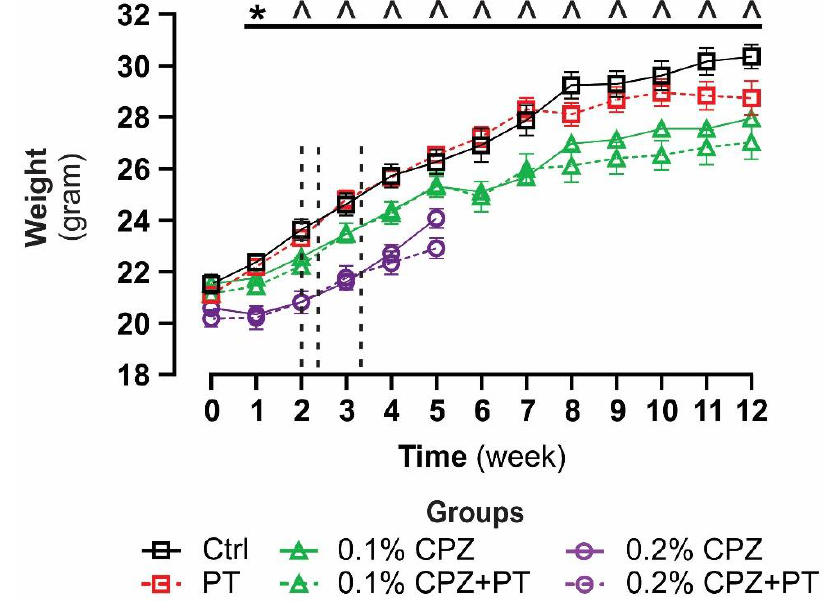
Figure 1. Body weight changes induced by CPZ-feeding. All mice gained weight over time. Groups fed the highest dose of CPZ(±PT) in each experiment gained weight significantly more slowly compared to other groups. Vertical dash lines indicate the timing of individual PT injections (i.e., days 14, 16, and 23). Data are expressed as mean ± SEM. Two-way ANOVA and Tukey post hoc analysis were used to determine differences among groups (* p < 0.05, ^ p < 0.0001, 5-week study n = 22 animals/group of which n = 12 animals/group continued feeding for 12 weeks).